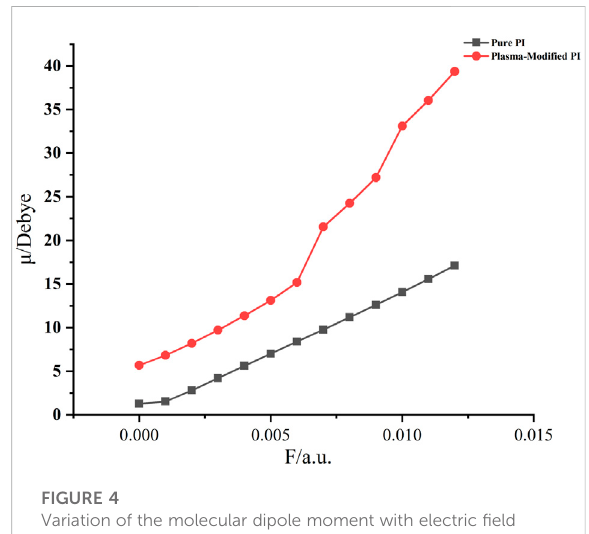
FIGURE 3 Variation of total molecular energy with electric fi eld intensity.